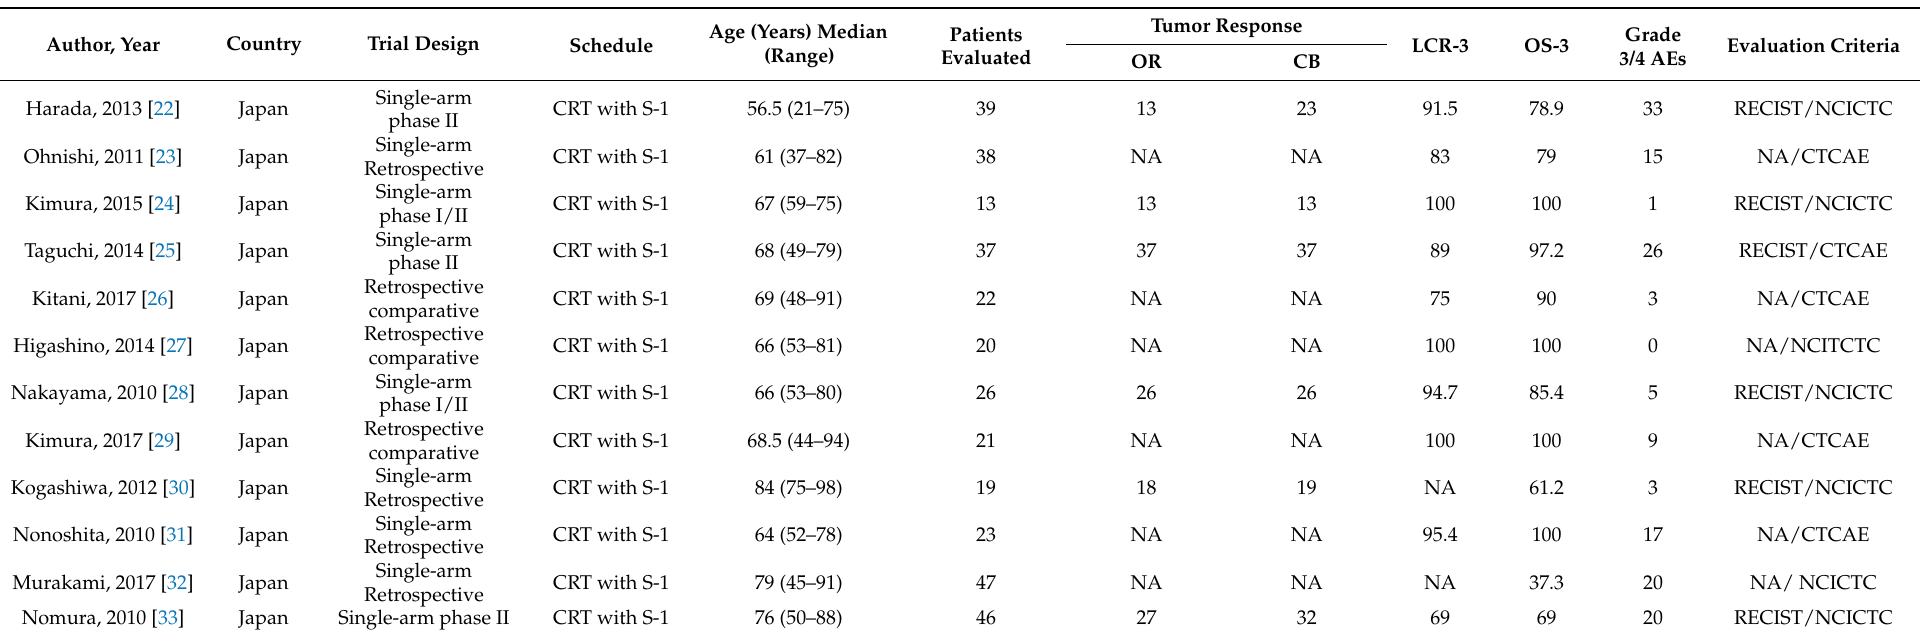
Table 1. Characteristics of the trials including in the